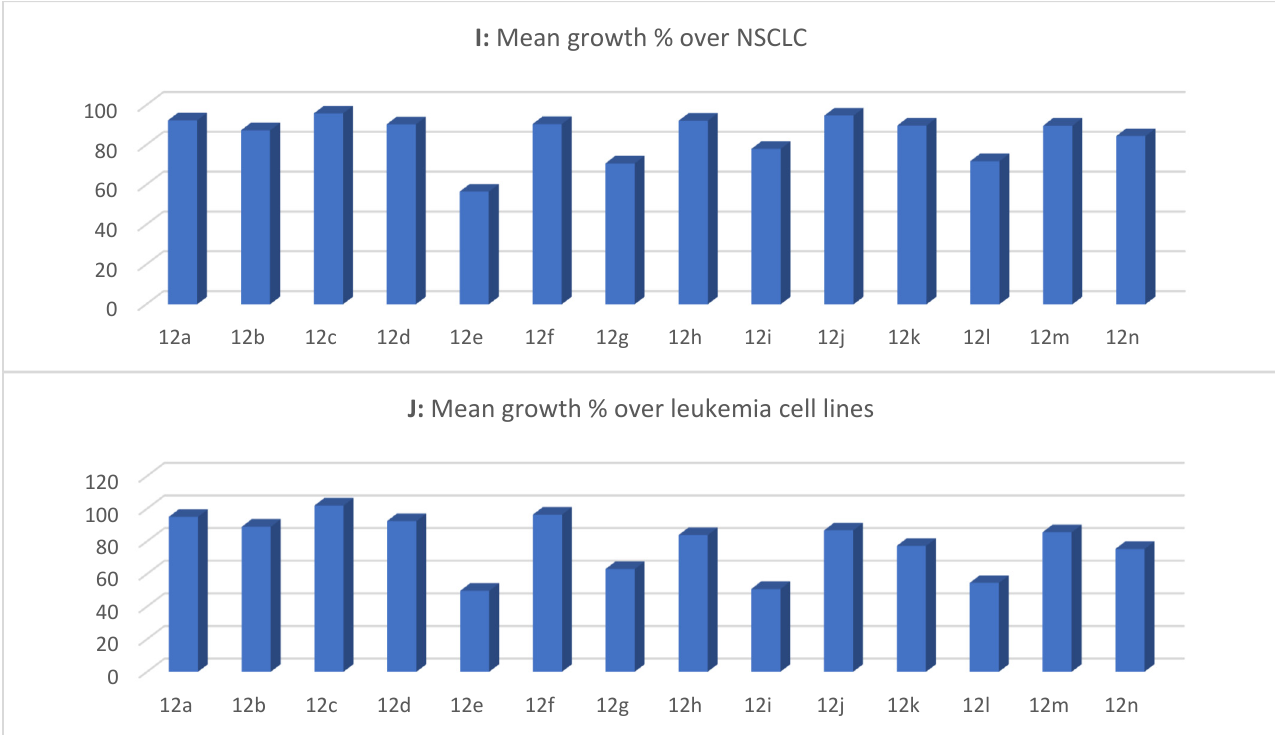
Figure 2. Effect of the target compounds 12a–n over NCI 60 cell lines. ( A ) Mean growth percentage over 60 cell lines. ( B ) Mean growth percentage over breast cancer cell lines. ( C ) Mean growth percentage over prostate cancer cell lines. ( D ) Mean growth percentage over renal cancer cell lines. ( E ) Mean growth percentage over ovarian cancer cell lines. ( F ) Mean growth percentage over melanoma cell lines. ( G ) Mean growth percentage over colon cancer cell lines. ( H ) Mean growth percentage over CNS cancer cell lines. ( I ) Mean growth percentage over NSCLC cell lines. ( J ) Mean growth percentage over leukemia cell lines. (See Tables S1 and S2 for detailed cell lines).